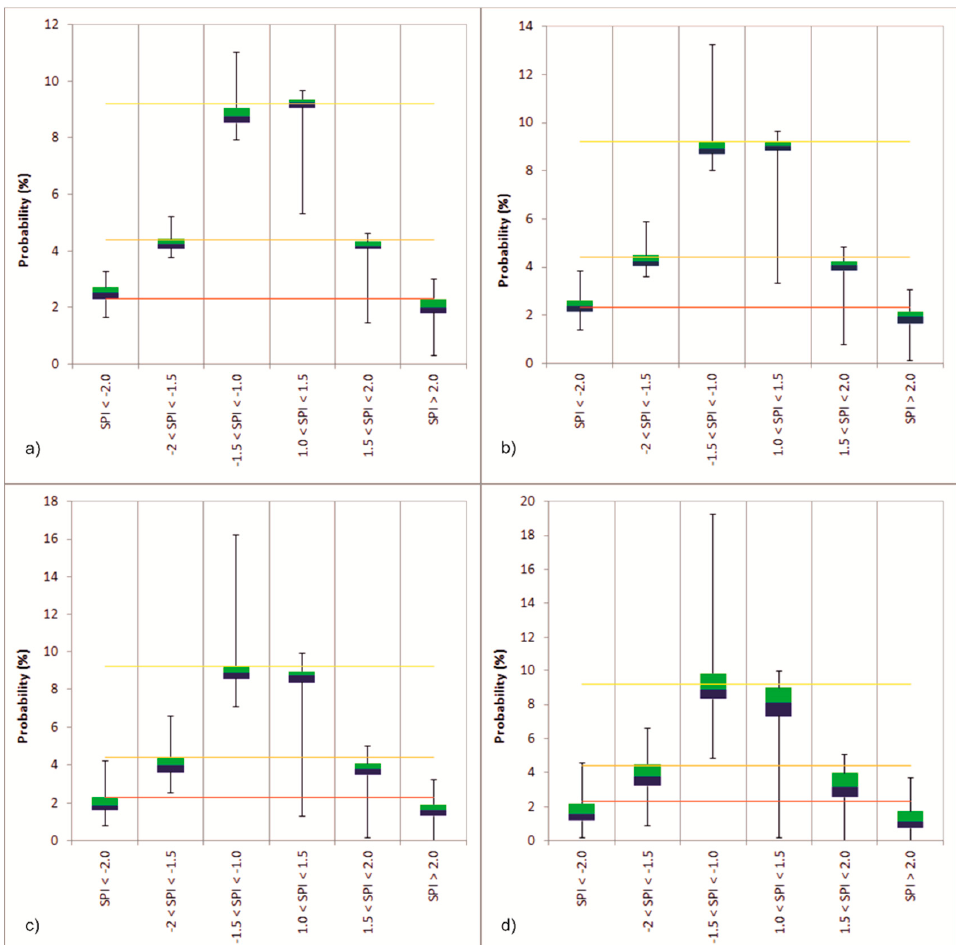
Figure 3. Box-plots of the regional occurrence probabilities of Extreme, Severe and Moderate drought and wet conditions for the 3-month ( a ), 6-month ( b ), 12-month ( c ) and 24-month ( d ) SPI. The lines indicate the theoretical values proposed by McKee et al. [32].